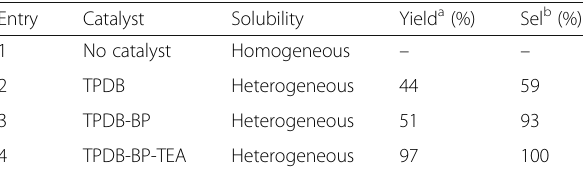
Table 1 Cycloaddition of CO 2 and PO catalyzed by various